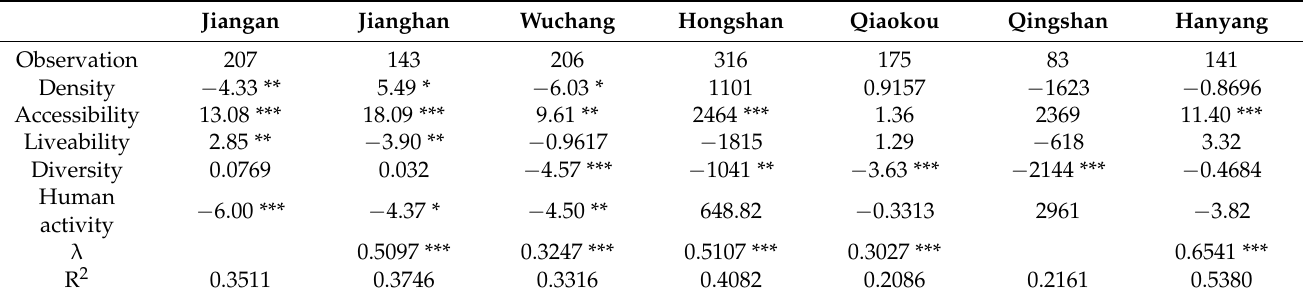
Table 4. Results of spatial regression for land surface temperature in different